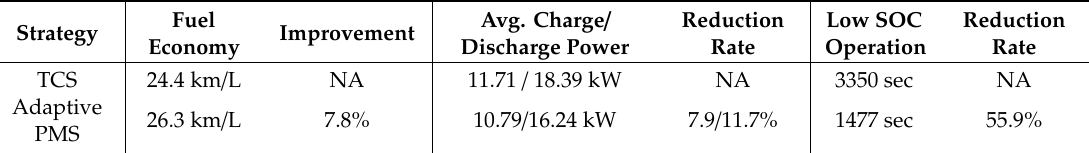
Table 11. Comparison of TCS and adaptive PMS for the four NEDC